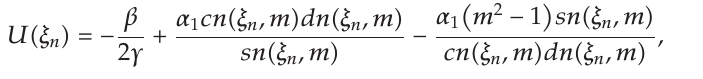
From (cid:5) 3.5 (cid:6) and (cid:5) 3.8 (cid:6) , the solution of (cid:5) 3.3 (cid:6) has the following